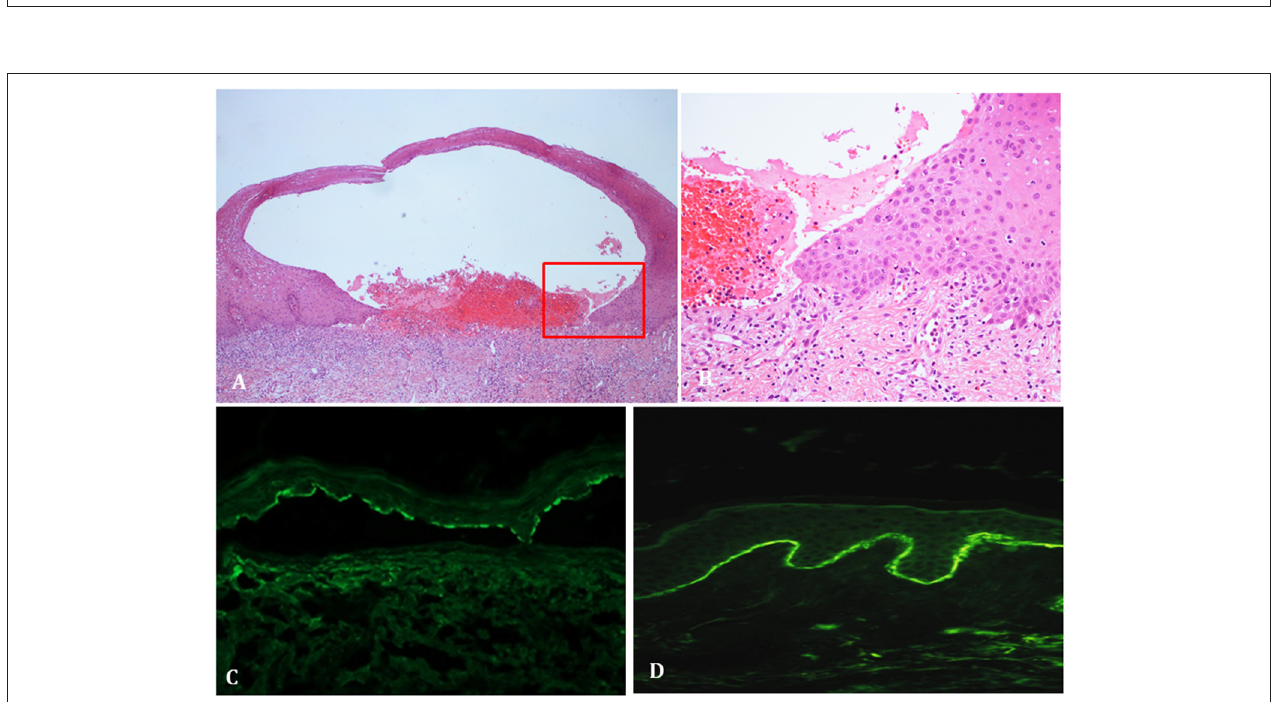
FIGURE 2 | Histopathological and immunopathological findings of vaccine-associated BP patients. (A) Histopathology showing subepidermal detachment accompanied by inflammatory infiltrates in the dermis (hematoxylin and eosin staining). (B) Close-up view revealing the supepidermal detachment with a dermal inflammatory infiltrate, mainly consisting of lymphocytes and eosinophils (hematoxylin and eosin staining). (C) Salt splin skin in indirect immunofluorescence shows IgG deposits along the dermo-epidermal junction. (D) Direct immunofluorescence shows linear IgG/C3 deposits along the dermo-epidermal junction.